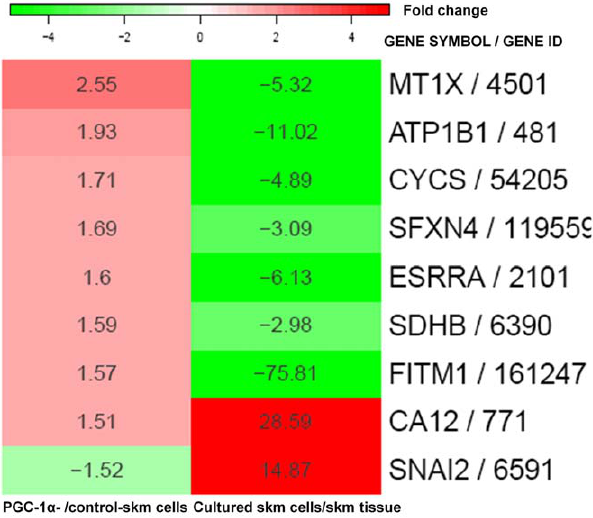
(MYH) and light (MYL) chain isoforms at higher levels than slow- twitch adult isoforms (MYH7 and MYL3), as shown previously [33]. Our finding contrasts with the activation in skm-specific PGC-1 a transgenic mice of contractile protein genes characteristic of type I fibers together with mitochondrial protein genes in putative type II muscles [5], or the increase in type IIx and IIb Table 3. Genes validated for differential expression in PGC-1 a -overexpressing cultured muscle cells.